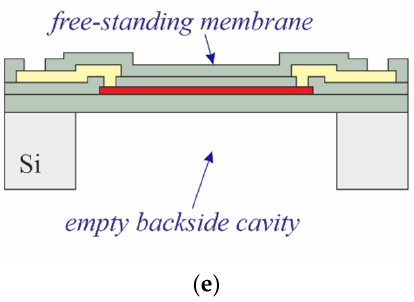
Figure 3. Fabrication of the sensor on silicon.